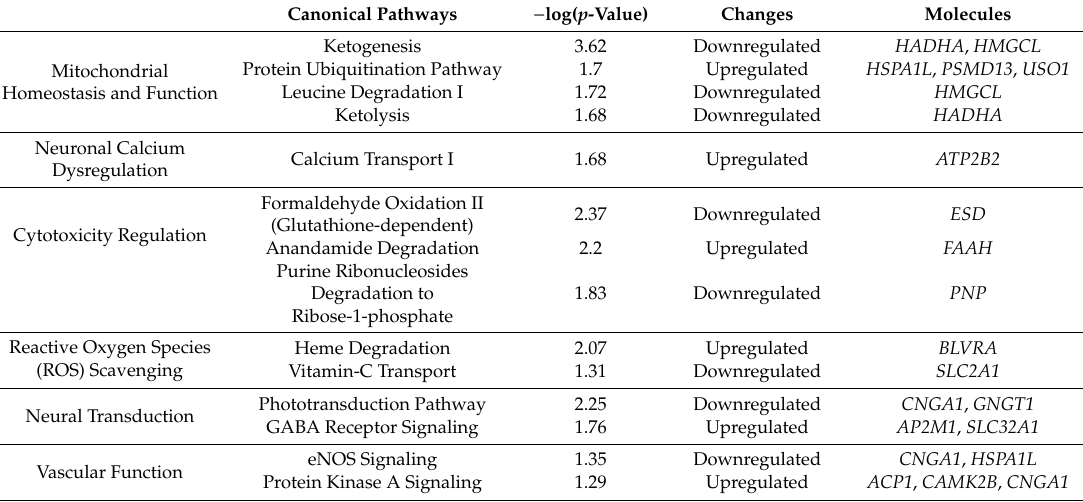
Table 4. List of most significantly modulated canonical pathways due to I /